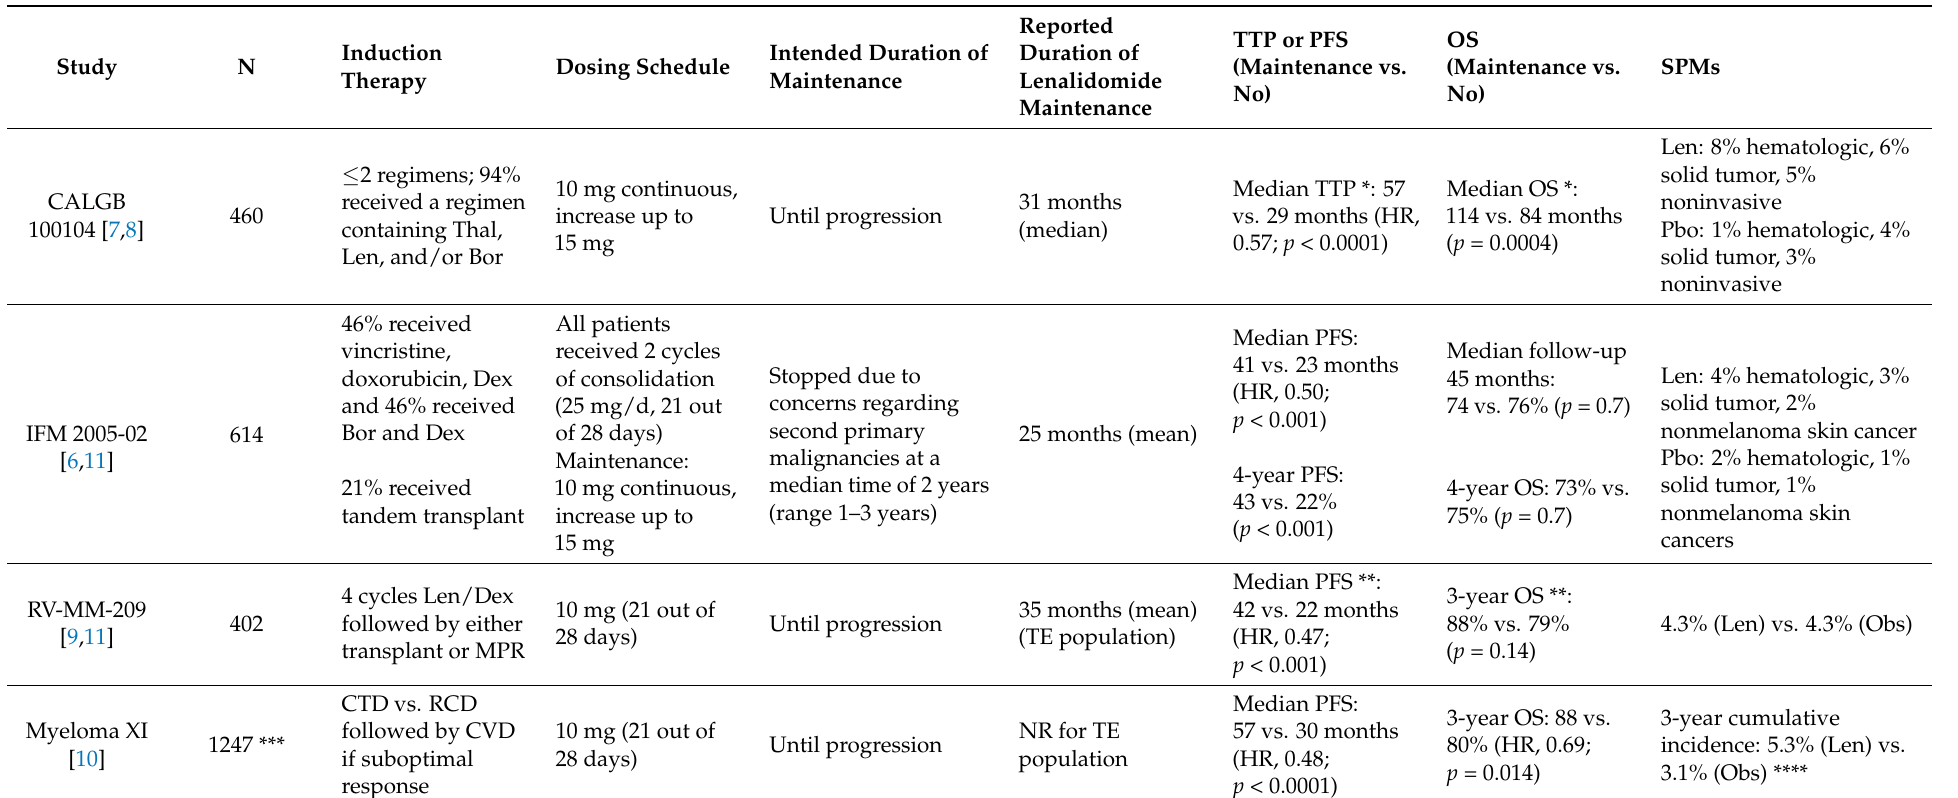
Table 1. Summary of randomized phase III trials evaluating lenalidomide maintenance after